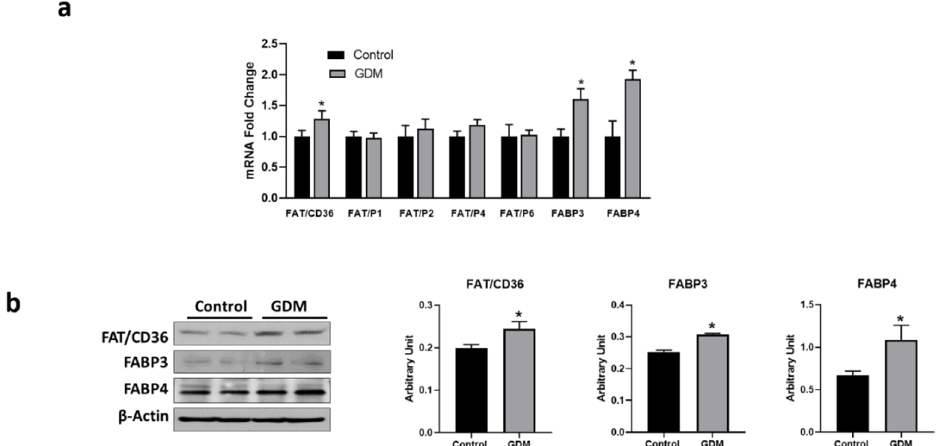
Figure 4. Changes in mRNA and protein levels of genes related to fatty acid transport in the trophoblasts exposed to control and GDM conditions. Primary human trophoblasts were cultured in standard conditions or with medium containing 25-mmol / L glucose and 10 − 7 -mol / L insulin for 72 h. ( a ) Real-time PCR was used to assess mRNA levels, and quantitation of mRNA expression was normalized relative to GAPDH. ( b ) Western blotting was used for protein quantification. Representative blots for proteins are shown at the lefr; blot densities obtained from densitometric scanning of proteins normalized to β -actin are shown at the right. Values are expressed as mean ± SD of three independent experiments. * p < 0.05 vs. control.